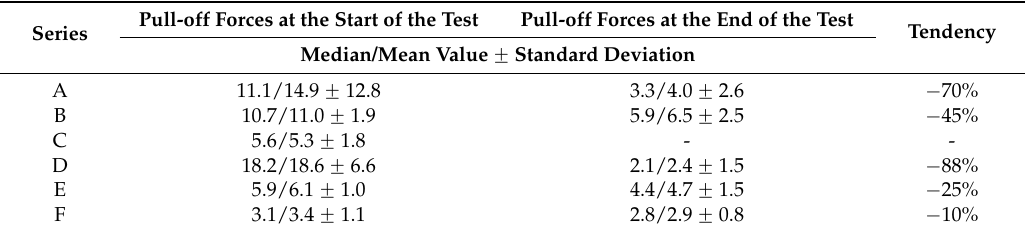
Table 4. Medians, mean values, and standard deviations of the pull-off forces (N) at the start and at the end of the tests; for the tendency, the averaged percentage by which the median of the initial value was reduced has been stated.